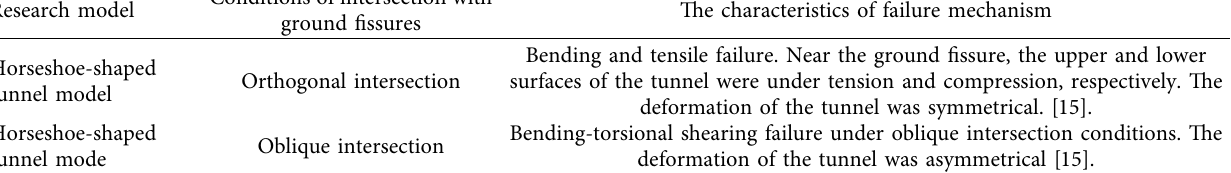
Table 3: The findings of the comparison between prior research and this paper. Research